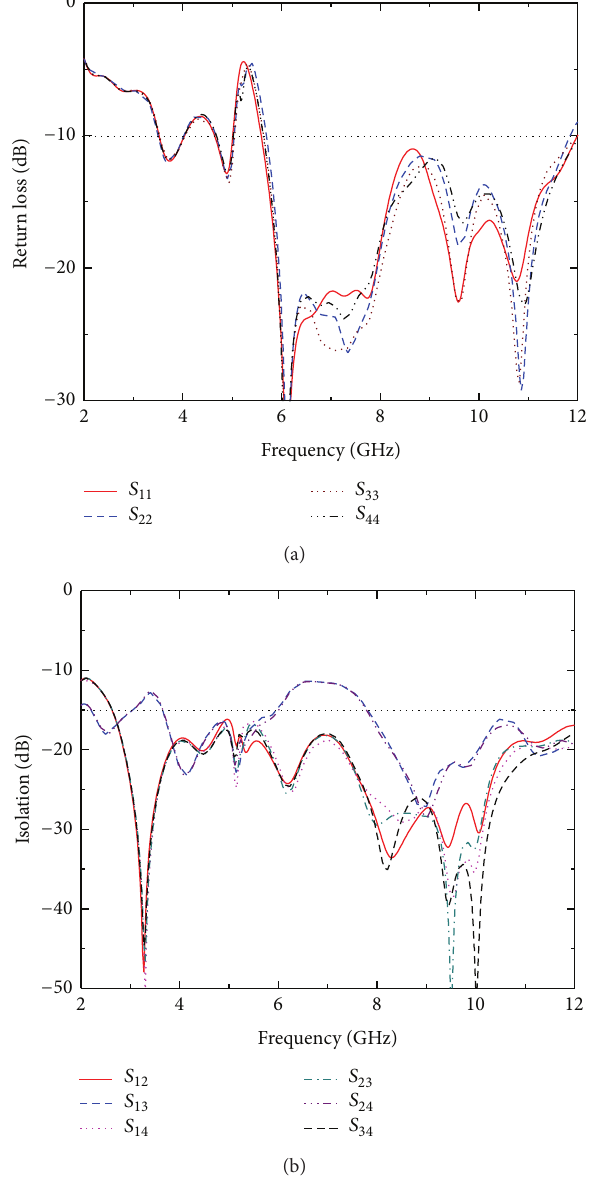
Figure 13: Simulated results of the initial MIMO antenna: (a) return loss and (b) isolation